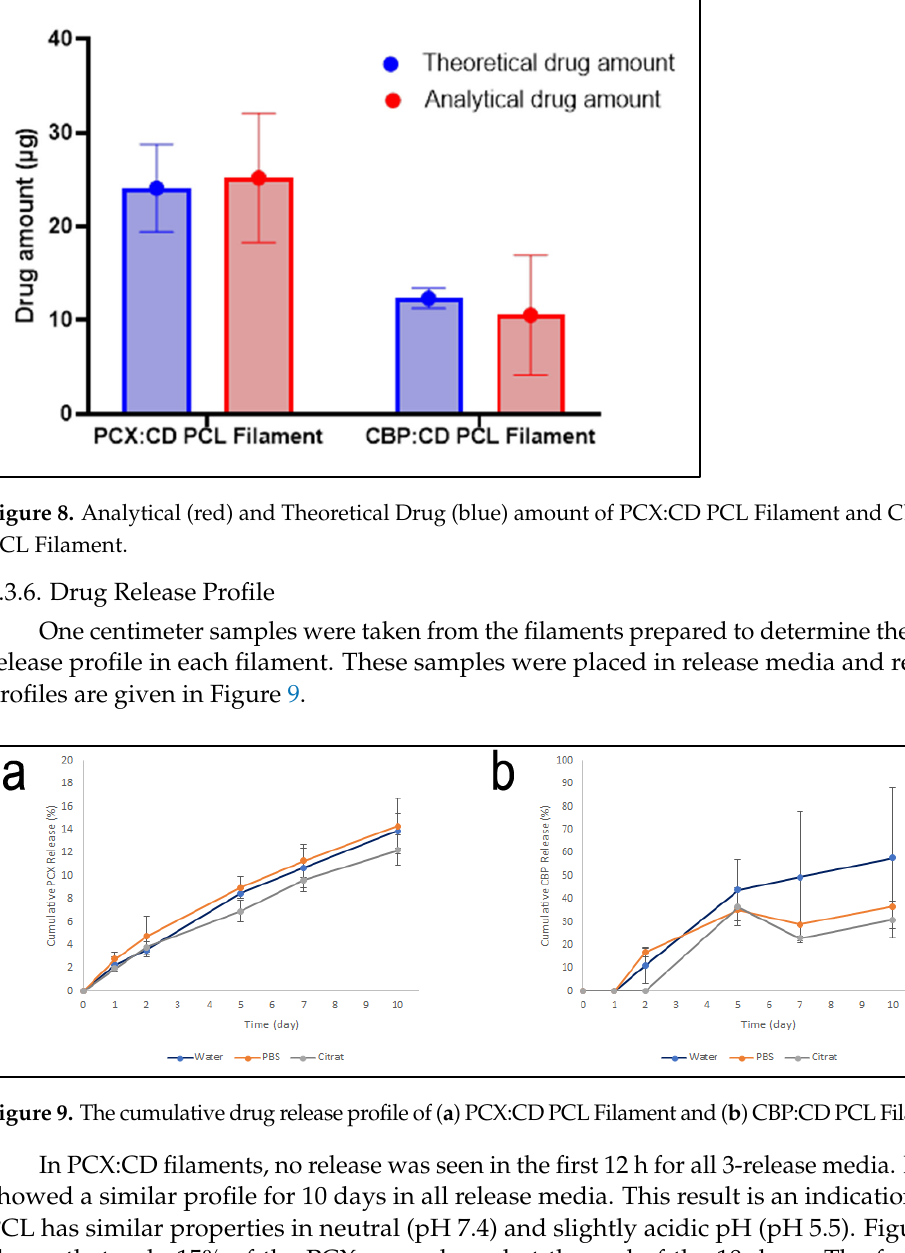
Figure 8. Analytical (red) and Theoretical Drug (blue) amount of PCX:CD PCL Filament and CBP:CD PCL Filament.